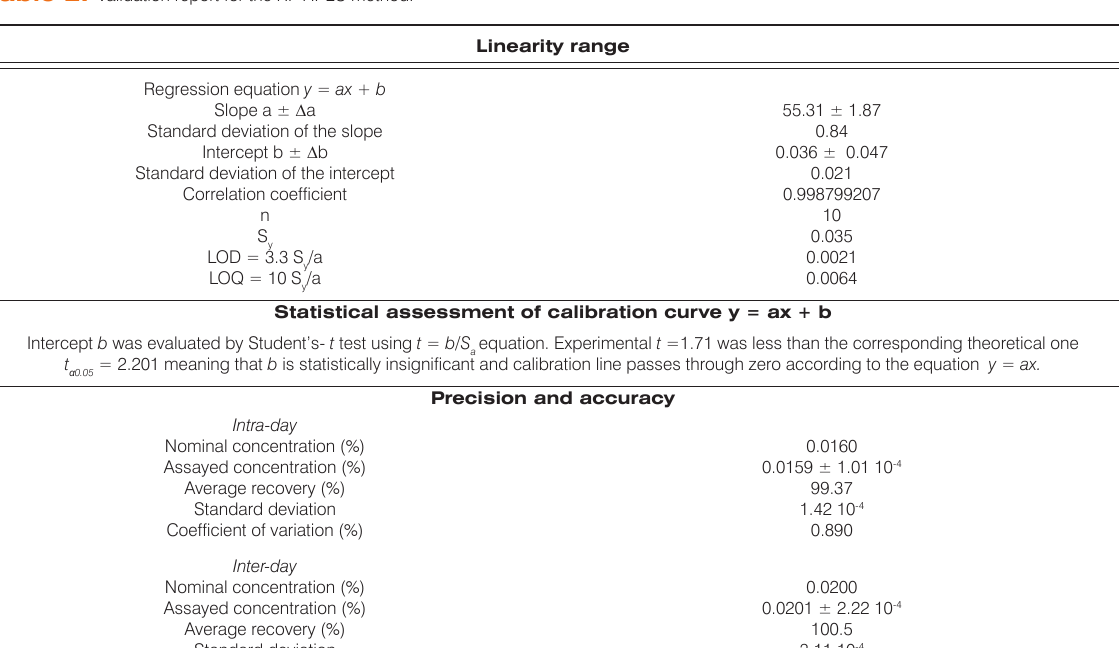
/p ) /[(p /p ) – (p /p ) ] = f(t) [sub] and its i IS t i IS 0 i IS t